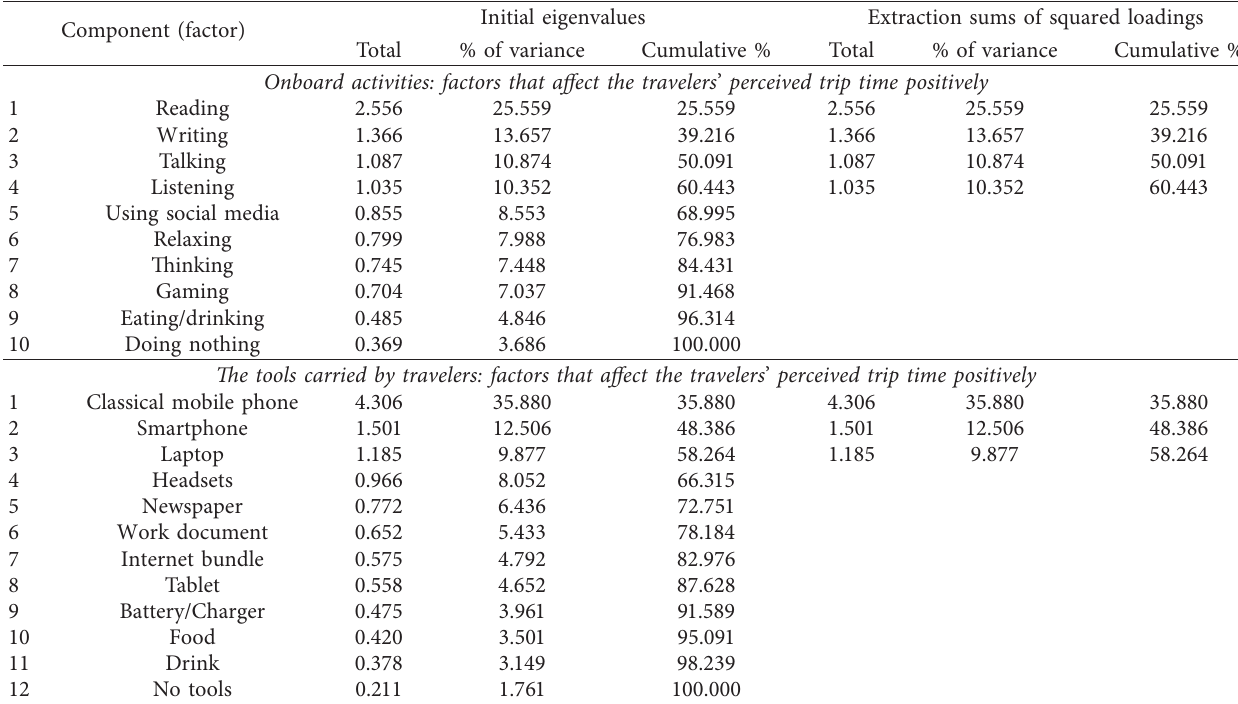
Table 20: Total variance explained by selected factors (onboard activities/tools carried by travelers) ∗ . Initial eigenvalues Extraction sums of squared loadings Component (factor)